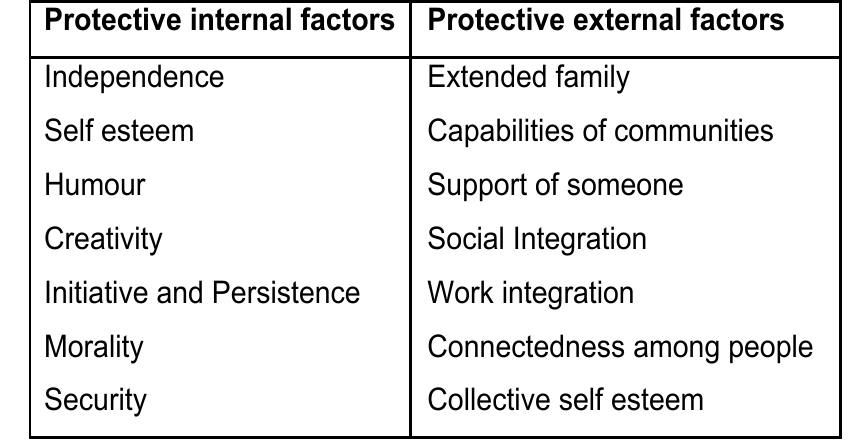
Table 1: Protective Factors of Resilience